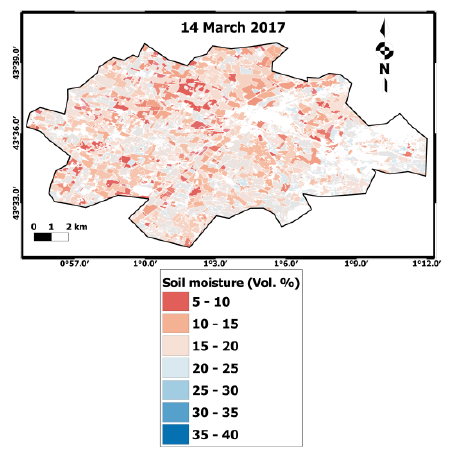
Figure 2. Retrieved soil moisture map obtained using change detection approach over Urgell site (Spain).